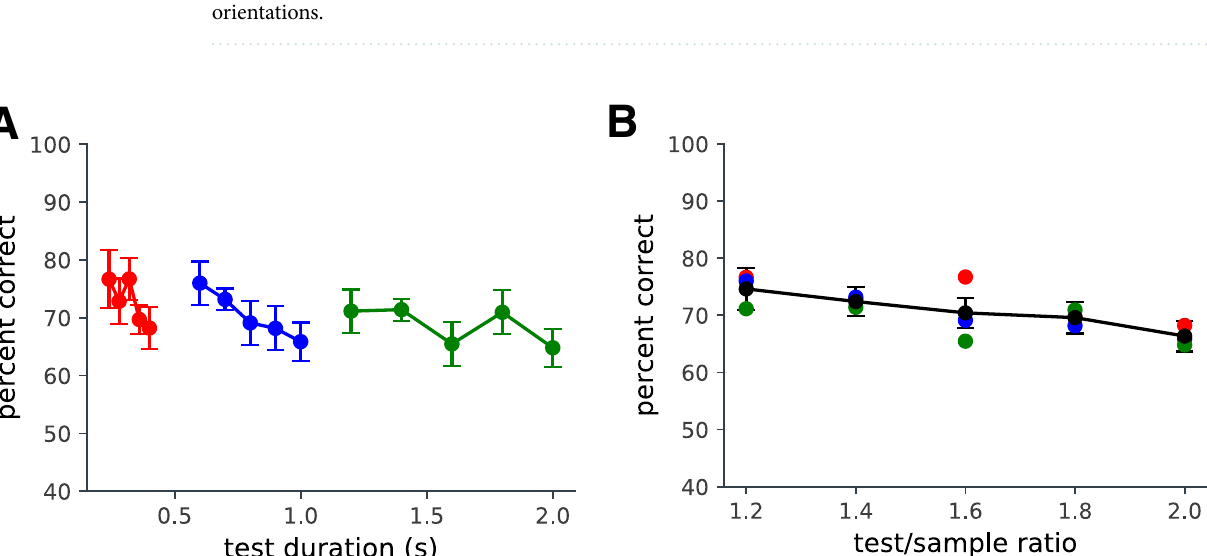
Figure 2. Experiment 3: The effect of display rate on playback direction discrimination. Observers indicated whether each clip presented was played forwards or reversed. Display rate describes the rate at which the frames were updated. The clips were presented at the 4 cardinal orientations. The black line is the mean of the 4 orientations.